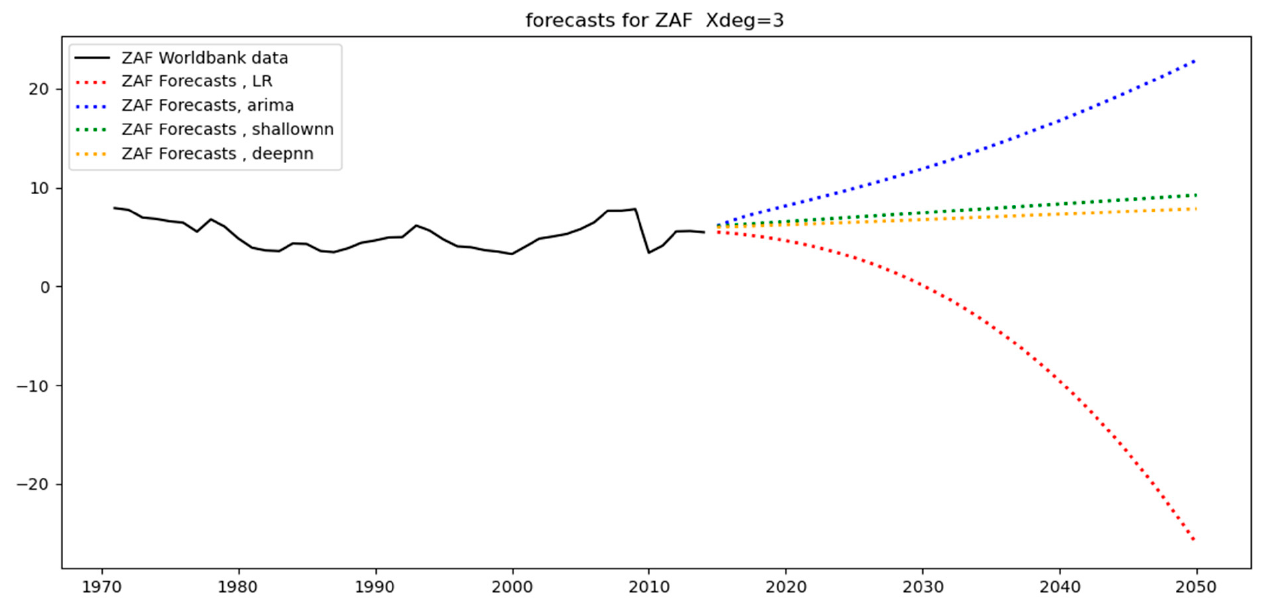
Figure 19. Forecasts for South Africa (ZAF), using linear regression (LR), ARIMA, shallow neural networks (shallownn), and deep neural network (deepnn) models (third-degree polynomial).